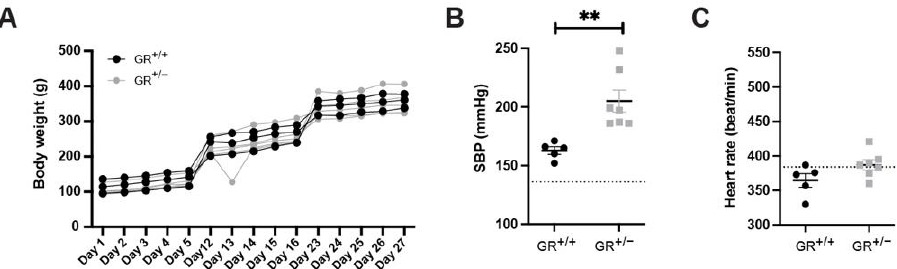
Figure 3. GR +/− rats develop salt-sensitive hypertension. ( A ) Body weight, ( B ) systolic blood pressure (SBP) and ( C ) heart rate of GR +/+ (n = 4–5) and GR +/− (n = 5–7) rats under high salt diet. The dotted lines ( B , C ) represent SBP and heart rate under standard diet. Values are indicated as mean ± SEM, and data were evaluated by two-way ANOVA and compared with Tukey test and differences assessed at ** p < 0.01.